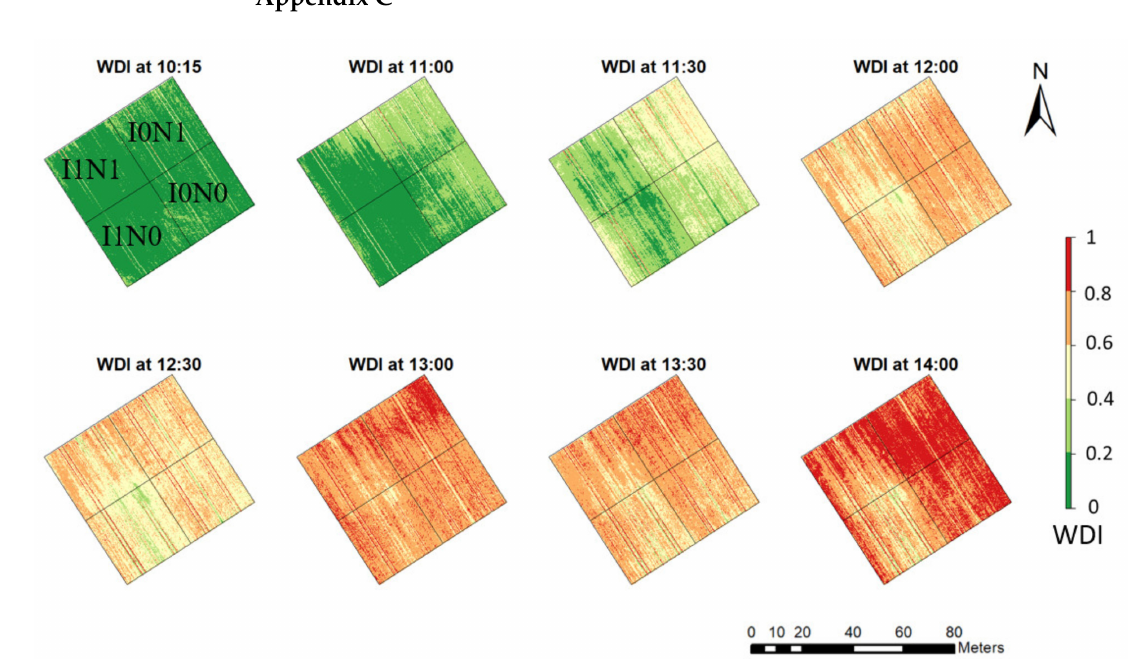
Figure A5. Spatiotemporal dynamics the WDI for winter wheat fields on the diurnal scale on 6 June 2018 in Denmark. I0 and I1 are minimum and optimum irrigation, respectively.